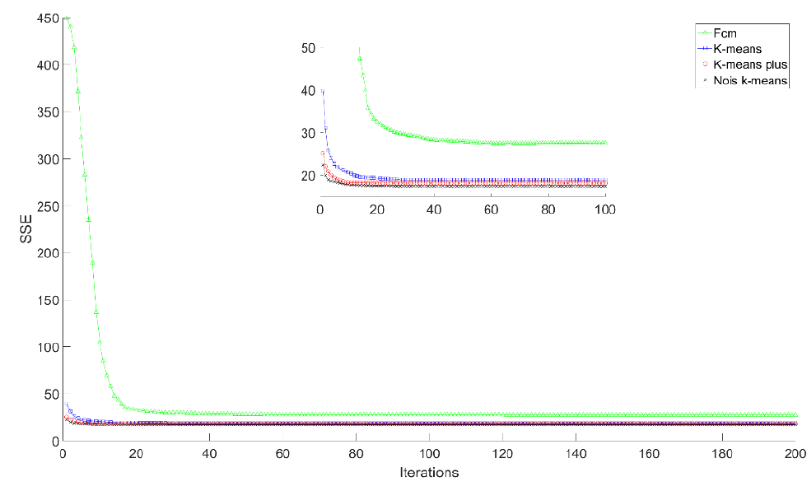
Figure 4. The SSE convergence curve for taxi GPS data (Aracaju (Brazil)).